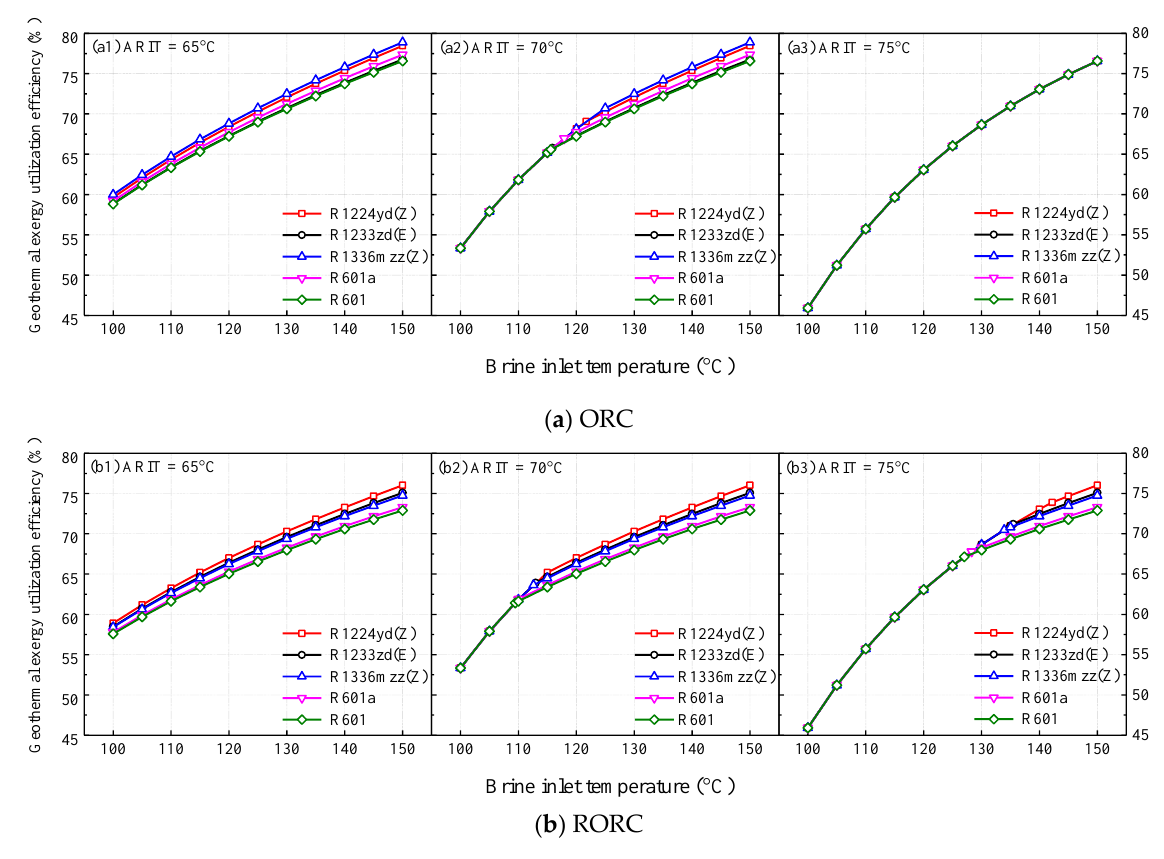
Figure 7. Geothermal exergy utilization efficiencies for ( a ) ORCs and ( b ) RORCs at the optimal conditions for various BITs and ARITs.